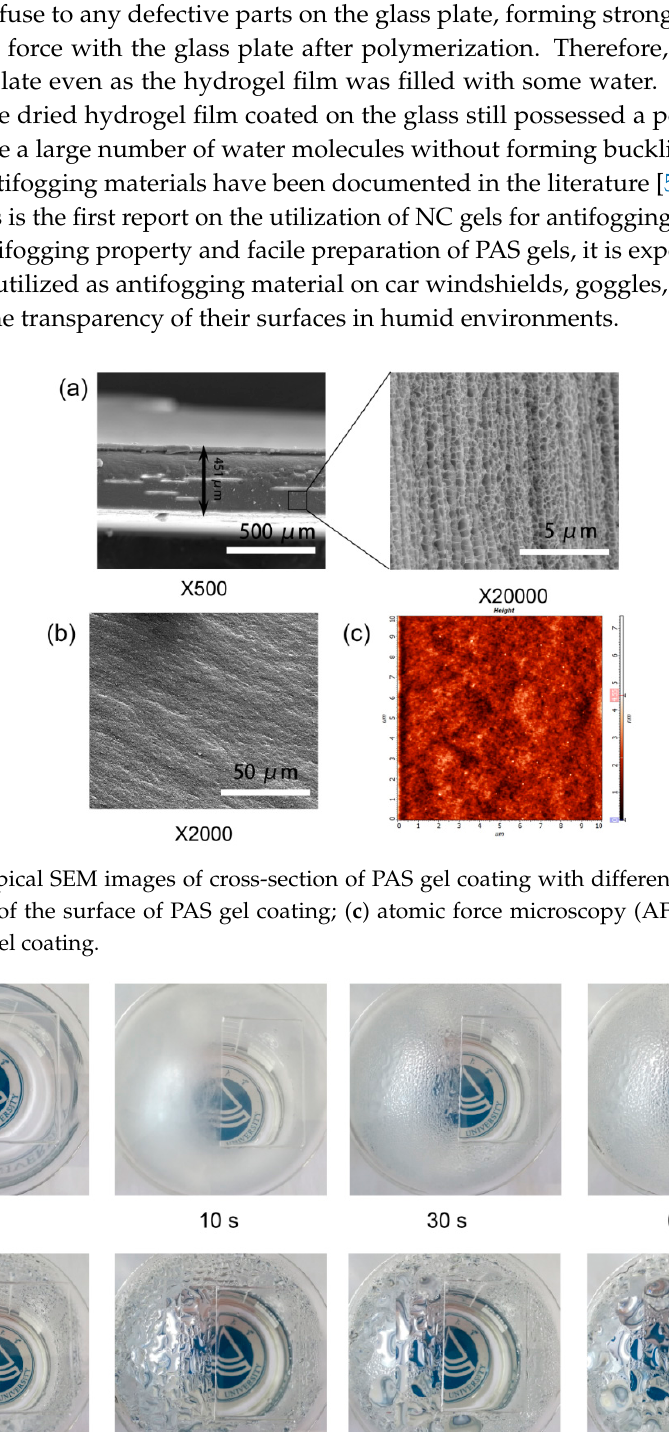
Figure 8. ( a ) Typical SEM images of cross-section of PAS gel coating with different magnifications; ( b ) SEM image of the surface of PAS gel coating; ( c ) atomic force microscopy (AFM) image of the surface of PAS gel coating.